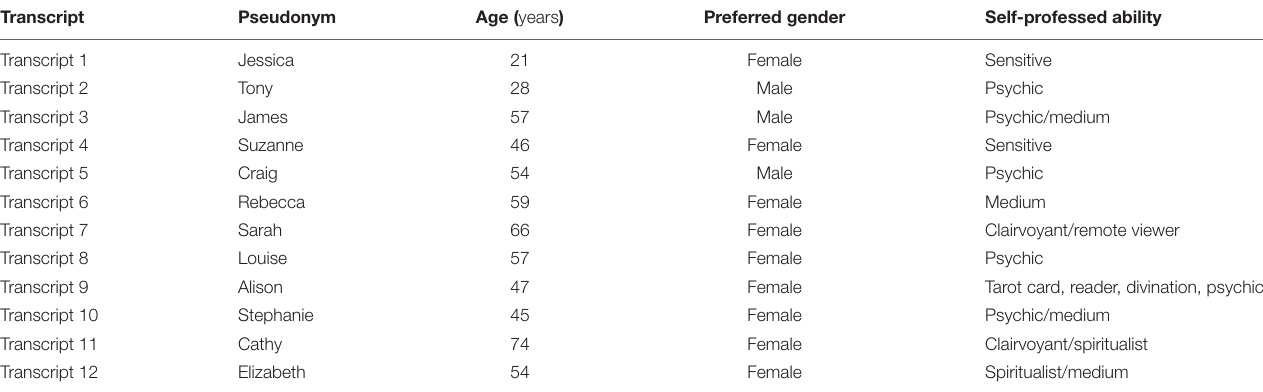
TABLE 1 | Participants and their professed